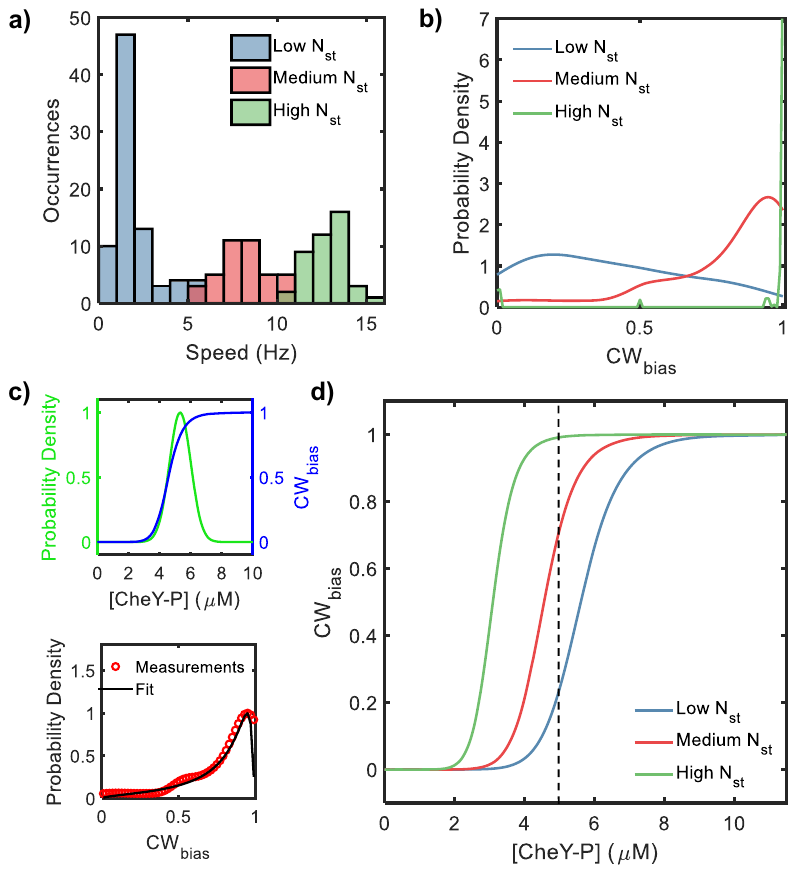
Fig. 2 Motor response curves shift with the number of bound stator units. a The number of stator units bound to individual motors was varied by controlling the expression of MotA-MotB from an inducible plasmid-borne promoter (see “ Methods ” section). We probed motor rotation with 2 μ m beads (high viscous load). Data on a total of n = 165 independent motors were collected and binned into three groups as per the speed of rotation, as indicated by the different colors: low speeds ( n = 81 independent motors, average torque ~ 270 pN nm, blue data), medium speeds ( n = 40 independent motors, average torque ~ 1150 pN nm, red data), and high speeds ( n = 44 independent motors, average torque ~ 1800 pN nm, green data). Each stator unit adds ~1.1 – 1.3 Hz to the overall rotation speed. b The probability density for the CW bias is indicated for each speed group. The distribution shifted to increased CW bias with an increasing number of bound stator units ( N st ). c Top : The variation in the CheY-P levels in a population (green curve) was described by a normal distribution ( μ = 5.3 ± 0.5 μ M, mean ± SEM; σ / μ = 0.13). The CW bias versus CheY-P relationship is described by a Hill equation (blue